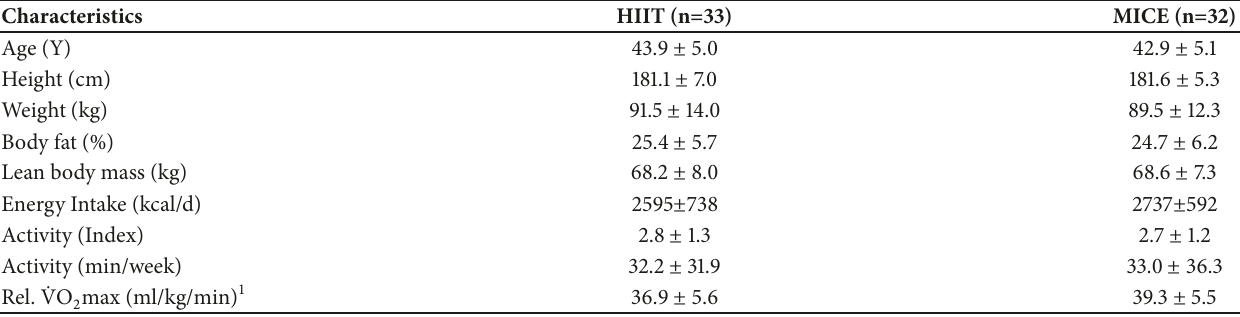
Table 1: Baseline characteristics of subject groups. 1 However, in five subjects each per group a plateau of oxygen consumption could not be